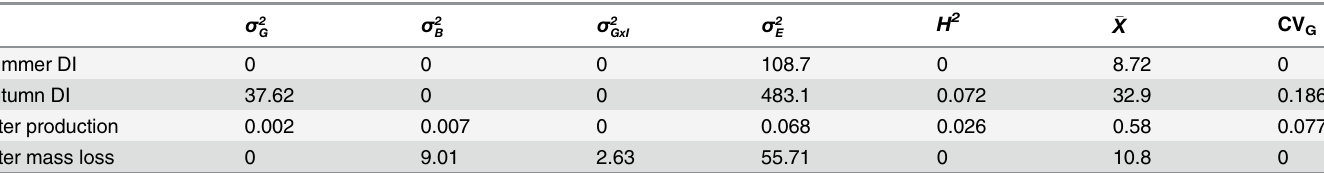
Table 2. Variance components ( σ 2 ), broad-sense heritability ( H 2 ), phenotypic mean ( (cid:2) X ) and the coef fi cient of genotypic variance (CV G ) of B. pendula insect herbivore damage index (DI), litter production and litter mass loss (G = genotype, B = block, I = insecticide, E = error, or residual).